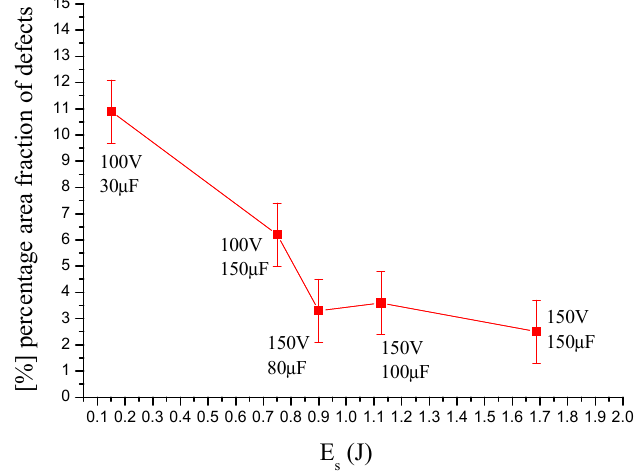
Figure 9. Percentage area fraction of defects as a function of spark energy (E s ) for WE43 deposits.